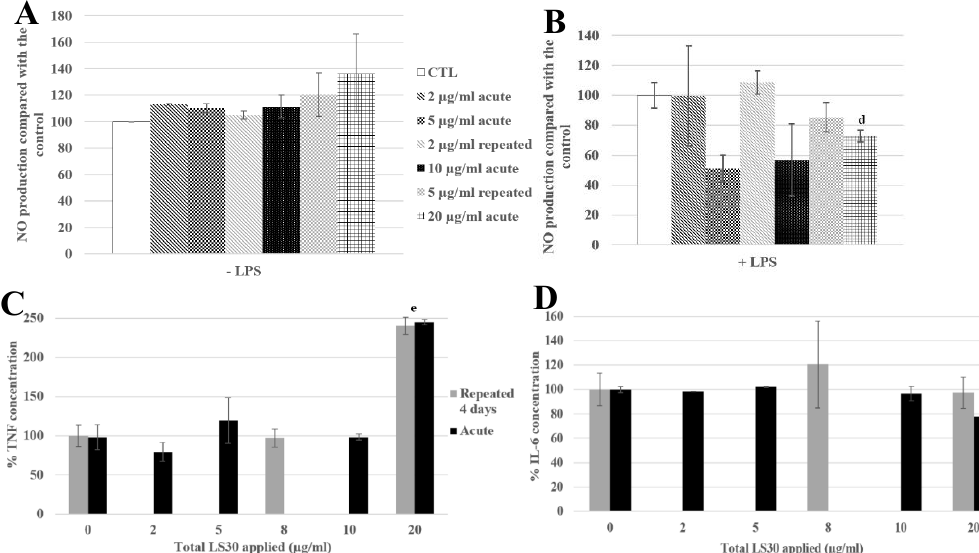
Figure 8. 4-day chronic exposure of RAW264.7 to LS30 NP and 18h to LPS compared with silica acute exposure. ( A , B ) NO dosage with the Griess reagent by spectrophotometry without or with LPS stimulation (d: CTL versus acute 20 µg/mL, p -value < 0.01). ( C ) TNF releases of RAW264.7 cells exposed to LS30 only, measured by flow cytometry (e: repeated 5 µg/mL and acute 20 µg/mL versus CTL, p -value < 0.01) . ( D ) IL-6 release measurement of LPS stimulated cells by flow cytometry (f: CTL versus acute 20 µg/mL, p -value < 0.01).